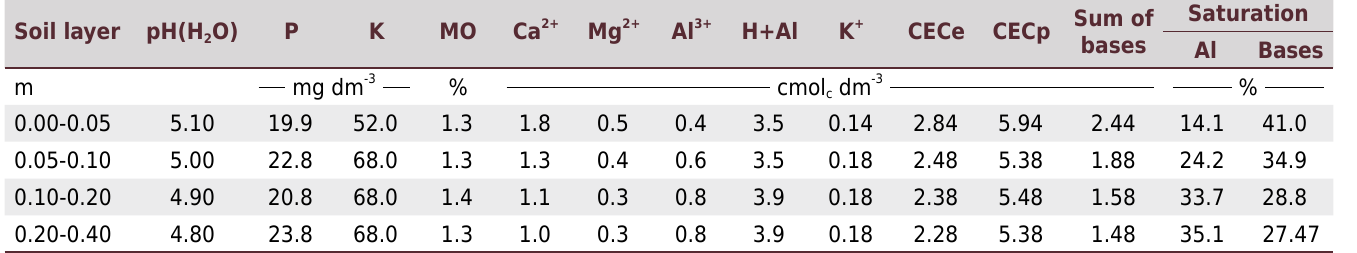
Table 2. Soil chemical properties at five locations in the study area before treatments allocation Soil layer pH(H 2 O) P